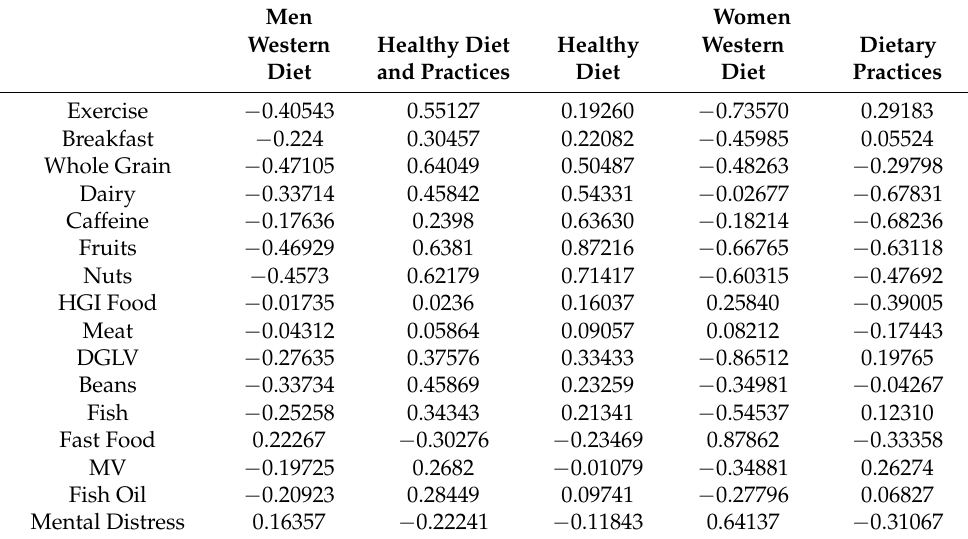
Table 3. K-means clustering mean values for mature men and